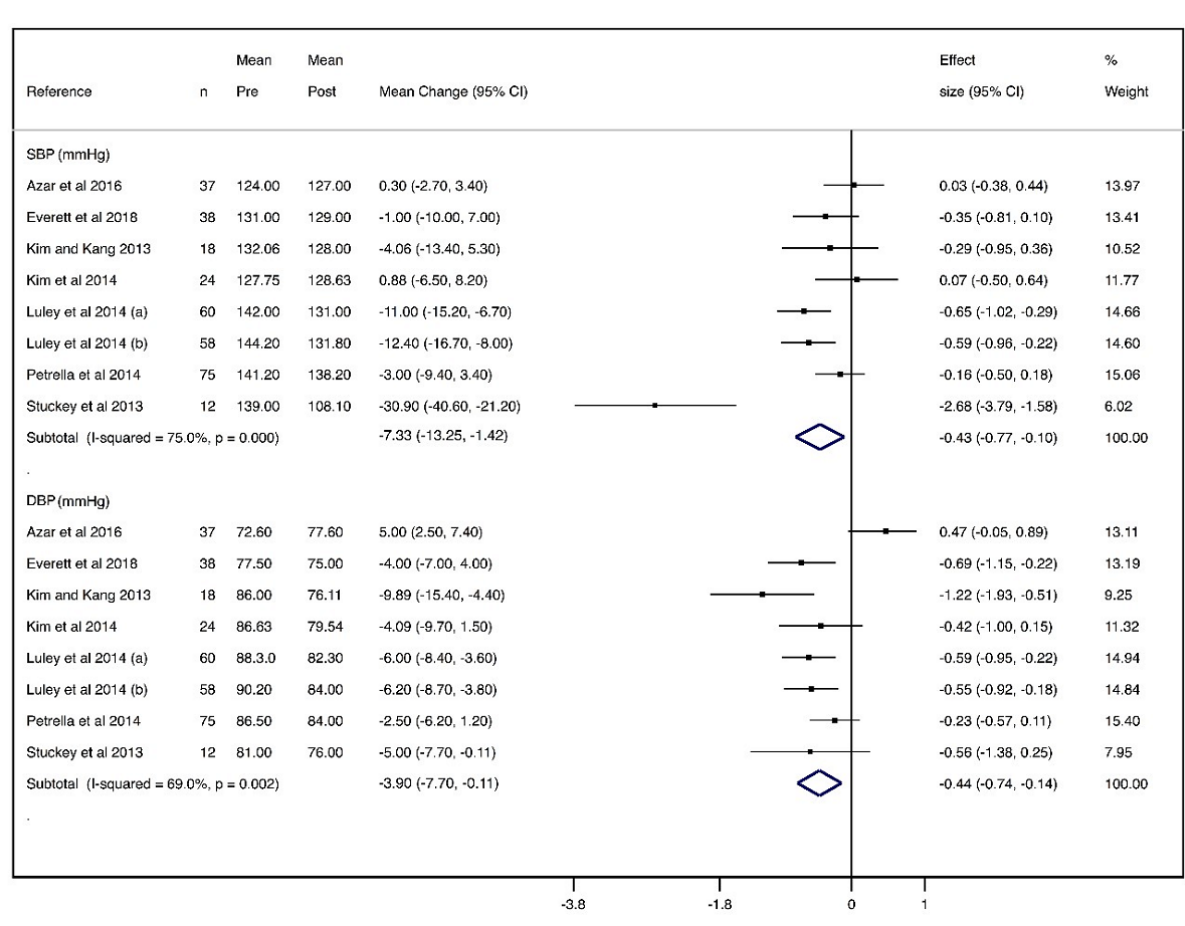
Figure 4. Forest plot of meta-analysis of mean changes and effect sizes for blood pressure parameters. DBP: diastolic blood pressure; SBP: systolic blood